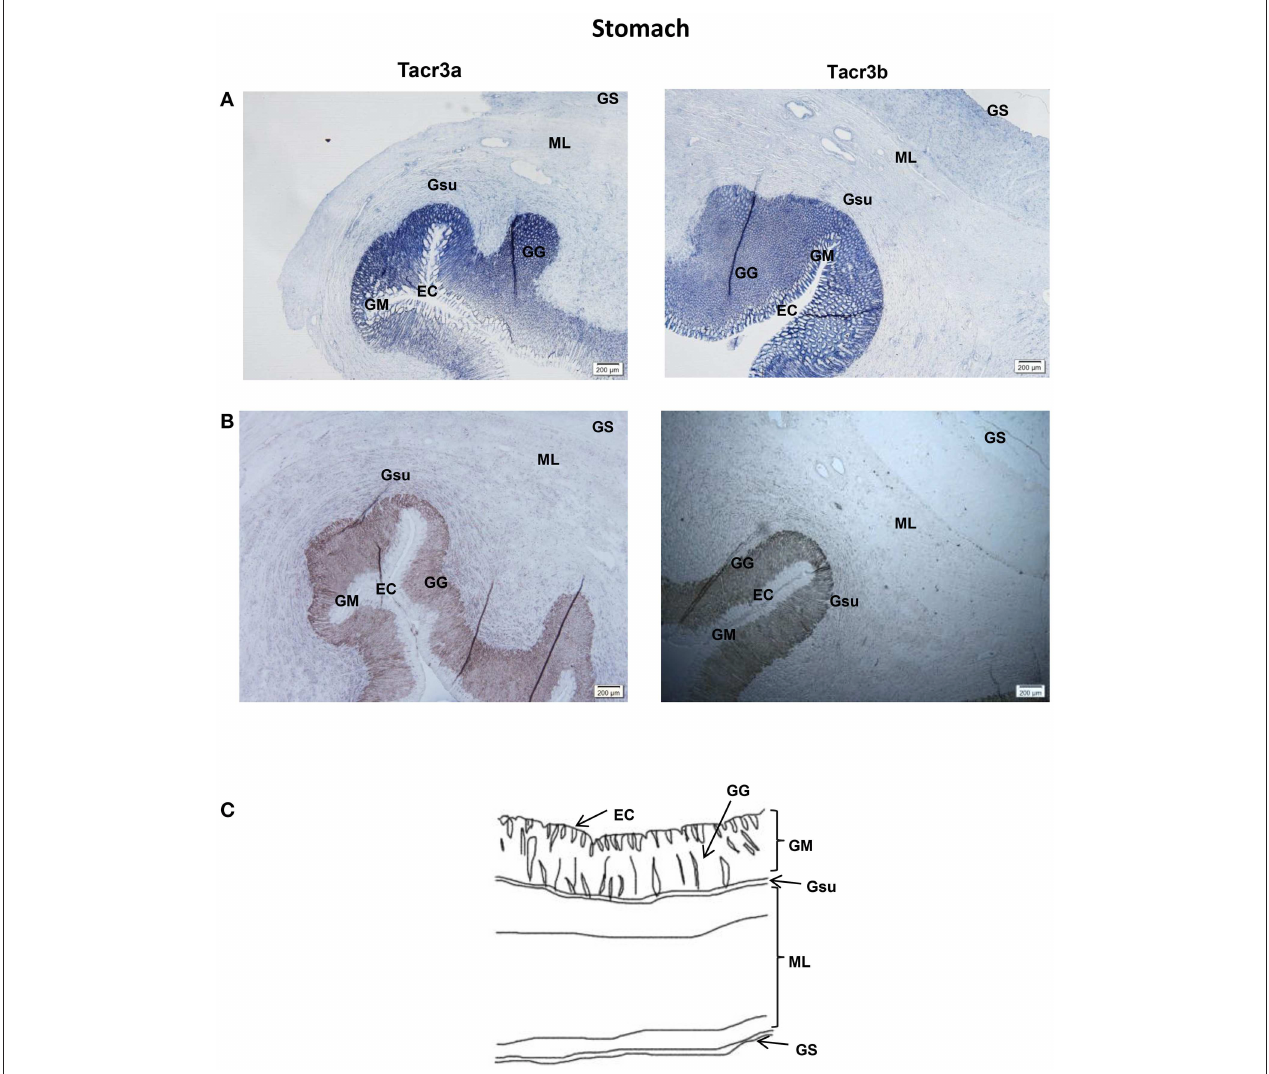
FIGURE 10 | Photomicrographs and schematic illustrations of the mRNA levels of tacr3s in the stomach of the spotted sea bass, as detected by in situ hybridization (ISH). Positive signal of tacr3a and tacr3b in the stomach (A) . Photomicrographs of tacr3a and tacr3b sense probe results in the stomach (B) . Schematic diagram for stomach histology (C) . ML, muscular layer; EC, epithelial cell; GM, gastric mucosa; Gsu, gastric submucosa; GS, gastric serosa; GG, gastric gland. some brain regions, and mainly located in several